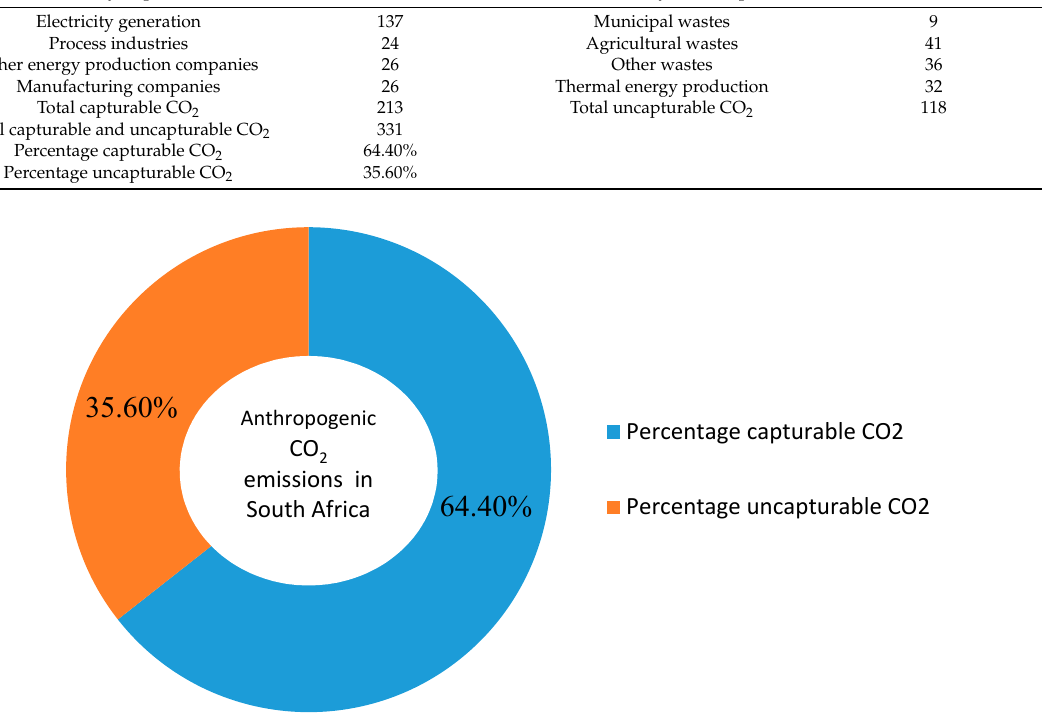
Figure 2. Percentage of capturable and uncapturable CO 2 in South Africa.